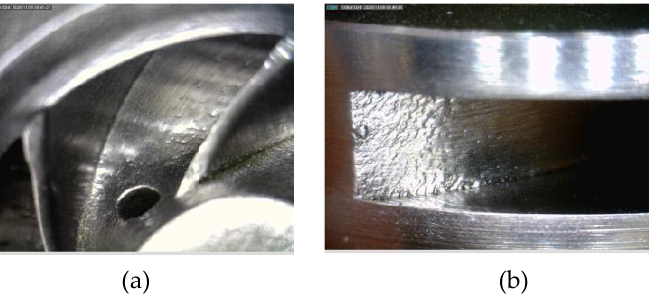
Figure 9. Details of first impeller (after tooling optimization) showing ( a ) interior surface and ( b ) pressure side.